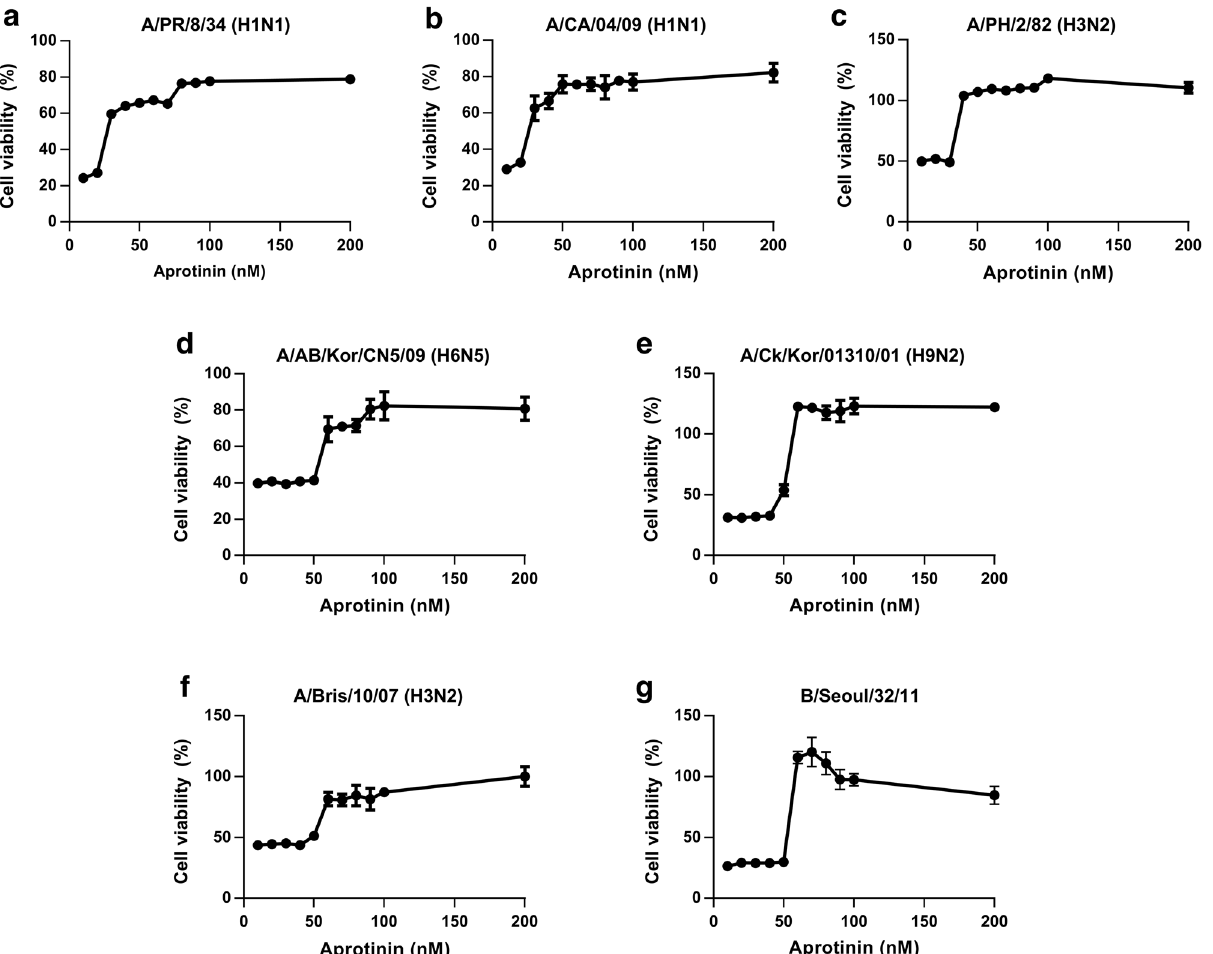
Figure 1. Dose-dependent effects of aprotinin against influenza viruses in vitro. Madin–Darby canine kidney (MDCK) cells were infected with ( a ) A/PR/8/34 (H1N1), ( b ) A/CA/04/09 (H1N1), ( c ) A/PH/2/82 (H3N2), ( d ) A/AB/Kor/CN5/09 (H6N5), ( e ) A/Ck/Kor/01310/01 (H9N2), ( f ) A/Bris/10/07 (H3N2), or ( g ) B/Seoul/32/11 (Yamagata-like lineage) and were treated with varying concentrations of aprotinin (10 ‒ 200 nM; n = 3 per dose) for 72 h. Viruses were inoculated at a dose of 100 (H6N5 and B/Seoul) or 1000 (all except H6N5 and B/Seoul) TCID 50 per well. Cell viability was measured using the EZ-Cytox reagent, and cell viability was calculated relative to the uninfected MDCK cell viability (cell-only control). TCID 50 : median tissue culture infectious dose.